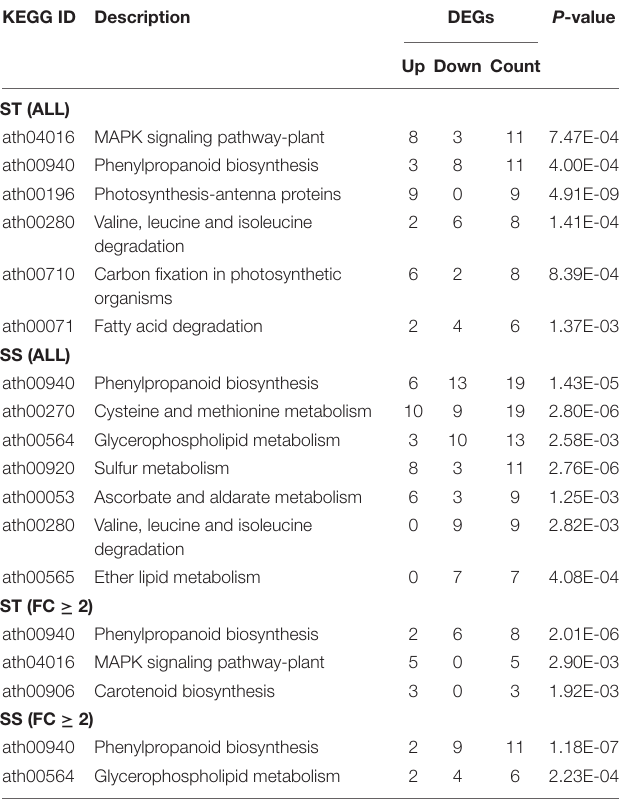
TABLE 1 | Kyoto encyclopedia of genes and genomes (KEGG) analysis of differentially expressed genes (DEGs) from salt-tolerant (ST), and salt-sensitive (SS)